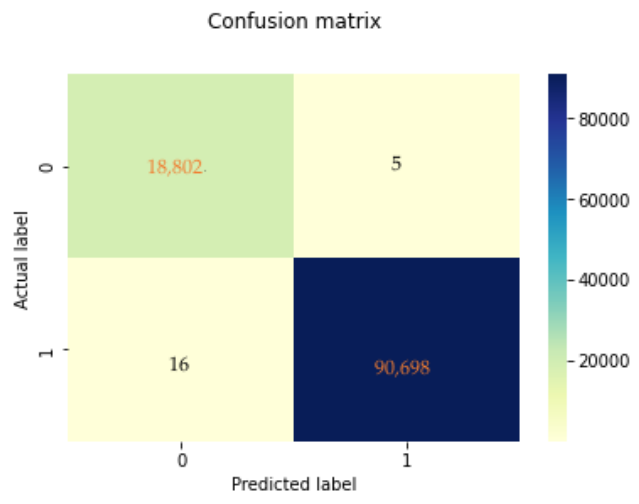
Figure 30. Changing the DDoS dataset confusion matrix.